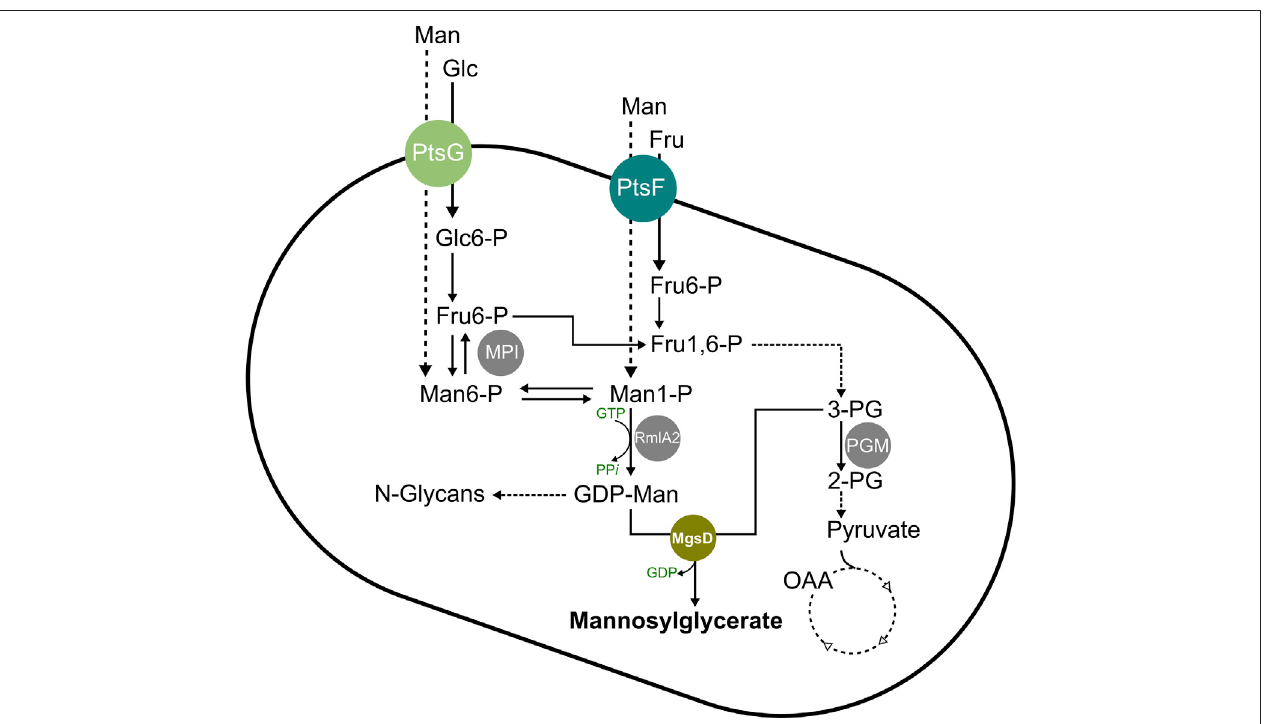
FIGURE 1 | Schematic overview of the mannosylglycerate synthesis pathway in C. glutamicum . Abbreviations: 2-PG, 2-phosphoglycerate; 3-PG, 3-phosphoglycerate; Fru, fructose; Fru1,6-P, fructose-1,6-bisphosphate; Fru6-P, fructose 6-phosphate; Glc, glucose; Glc6-P, glucose 6-phosphate; GDP, guanosine diphosphate; GTP, guanosine triphosphate; Man, mannose; Man1-P, mannose 1-phosphate; Man6-P, mannose 6-phosphate; MgsD, mannosylglycerate synthase (encoded by mgsD from Dehalococcoides mccartyi ); MPI, mannose 6-phosphate isomerase (encoded by manA ); OAA, oxaloacetate; PGM, phosphoglycerate mutase (encoded by pgm ); PP i , inorganic pyrophosphate; PtsF, fructose-speci fi c phosphoenolpyruvate-dependent phosphotransferase system (encoded by ptsF ); PtsG, glucose-speci fi c phosphoenolpyruvate-dependent phosphotransferase system (encoded by ptsG ); RmlA2, GDP-mannose pyrophosphorylase (encoded by rmlA